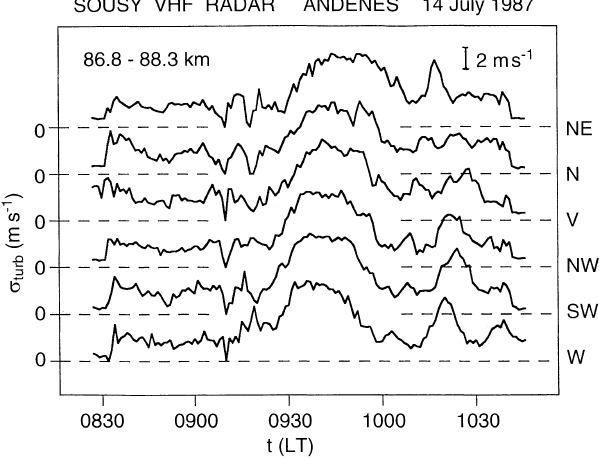
Fig. 7. Height integrated (86.2–88.3 km) time series of the turbulent component (cid:114) turb of the spectral width observed in all six